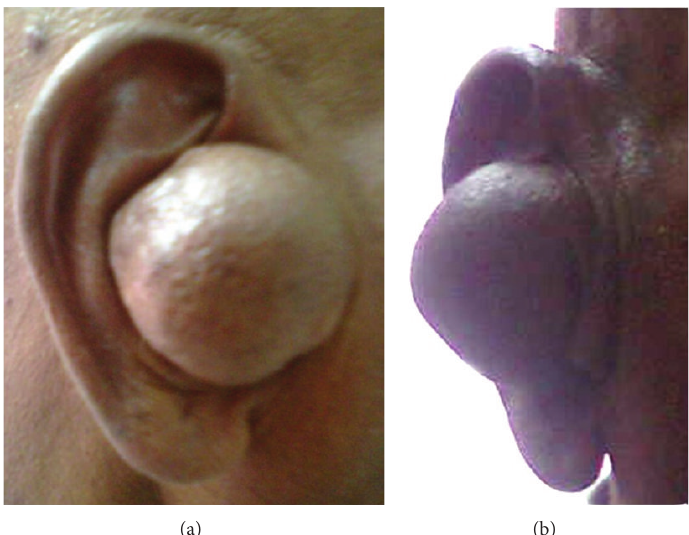
Figure 1: Preoperative photograph of the patient’s lateral view shows a spherical shaped swelling in the right ear obscuring the view of external auditory canal (a) and anteroposterior view shows that his tragus has been pushed anteroinferiorly by the tumor mass